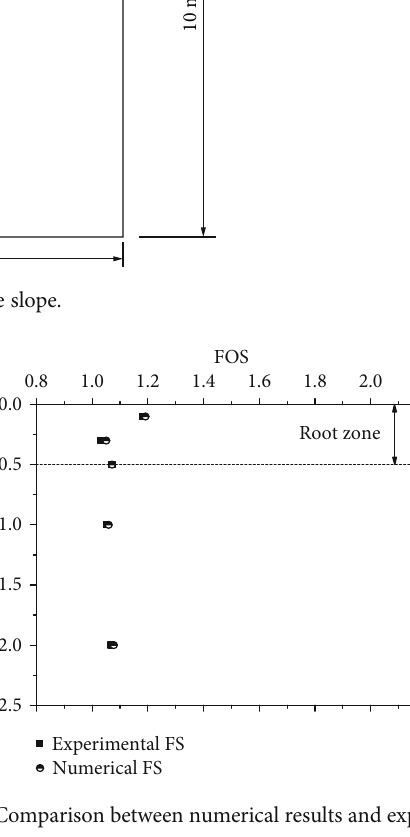
Figure 4: Comparison of FOS with di ff erent grids.